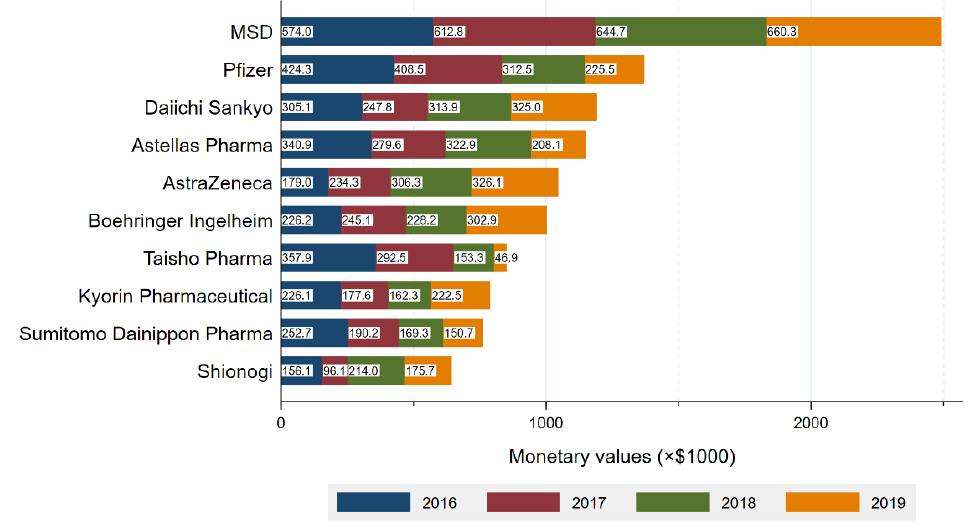
Figure 1. Total payment by company. MSD made the largest payments of $2,493,244 to 460 (28.5%) specialists. Pfizer with the second largest payments distributed a total of $1,376,045 payments to 267 (16.5%) infectious specialists. The average payments per specialist were the highest from FujiFilm Toyama Chemical ($7269), followed by MSD ($5456), Pfizer ($5154), Boehringer Ingelheim ($5002), and AstraZeneca ($4990). Payment categories by each company were described cations (8 drugs), followed by Daiichi Sankyo Company (5 drugs) and GlaxoSmithKline (5 drugs) (Table S1). There were moderately positive correlations between number of new or additional indications and (1) total payments (r(76) = 0.46, p < 0.001) and (2) number